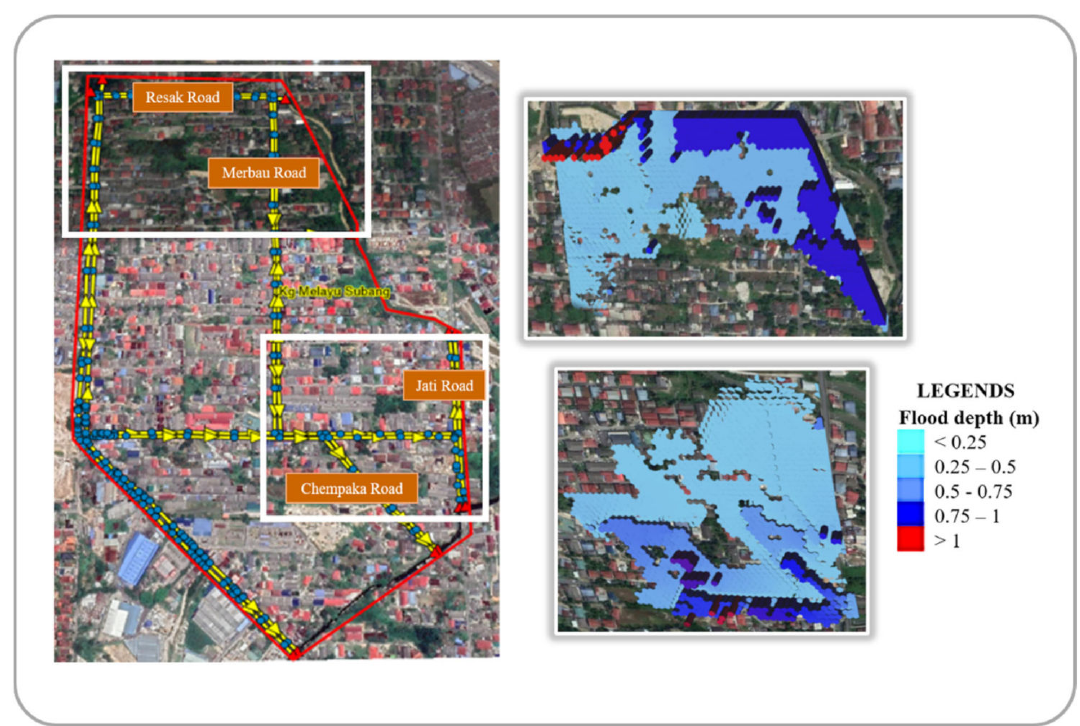
Figure 7. Bird’s eye view of simulation results showing flooding in Kampung Melayu Subang.